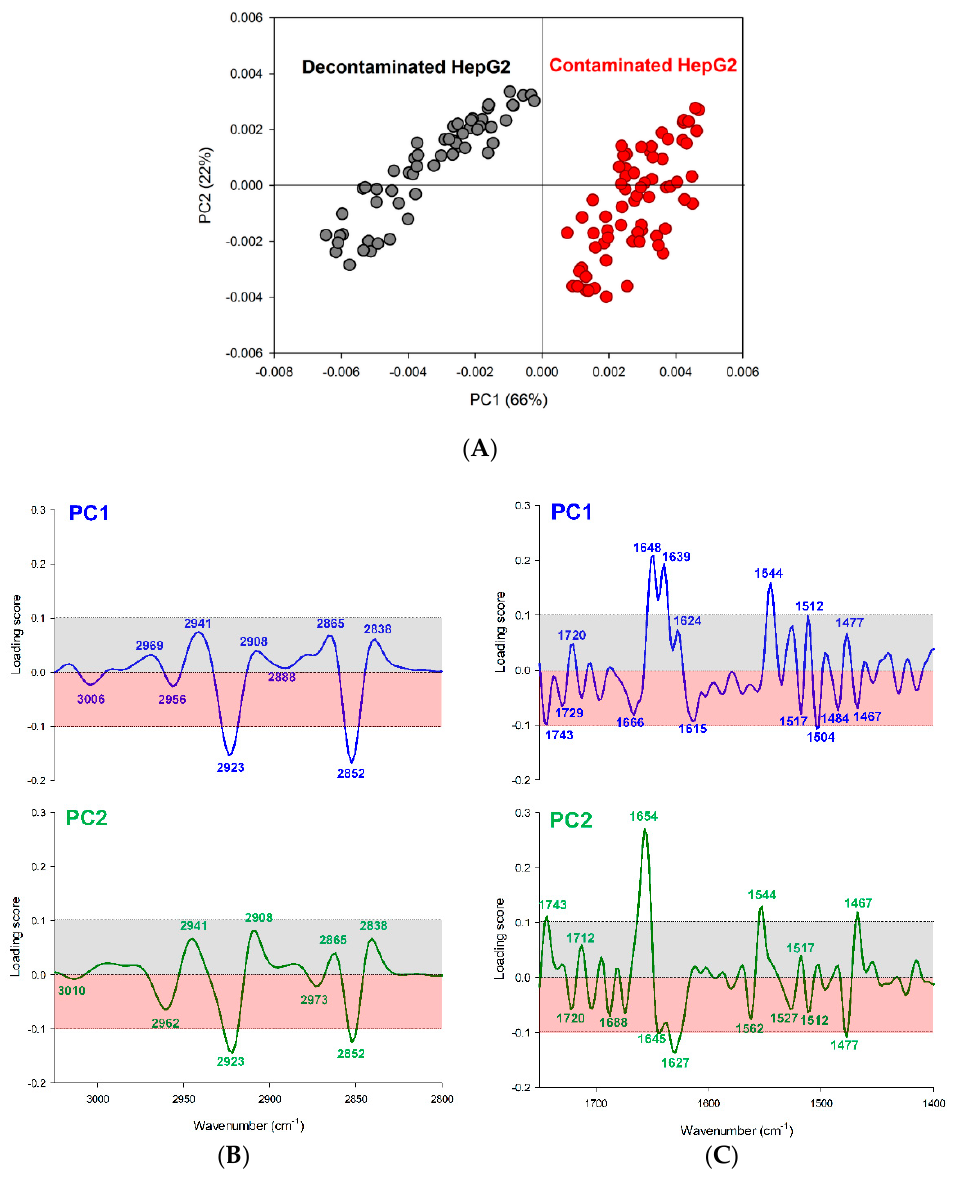
Figure 4. ( A ) Principal component analysis (PCA) score plot on PC1 and PC2 and ( B ) their relevant Figure 4. (A) Principal component analysis (PCA) score plot on PC1 and PC2 and (B) their relevant loading plots from the lipid and ( C ) protein regions represent the wavenumbers discriminating loading plots from the lipid and (C) protein regions represent the wavenumbers discriminating the the di ff erences between decontaminated (67 spectra from triplicate samples) and contaminated differences between decontaminated ( 67 spectra from triplicate samples ) and contaminated ( 58 (58 spectra from triplicate samples) HepG2 cells. The wavenumbers with loading scores ≥ 0.1 or ≤ − 0.1 spectra from triplicate samples ) HepG2 cells . The wavenumbers with loading scores ≥ 0 . 1 or ≤ − 0 . 1 are are significant .